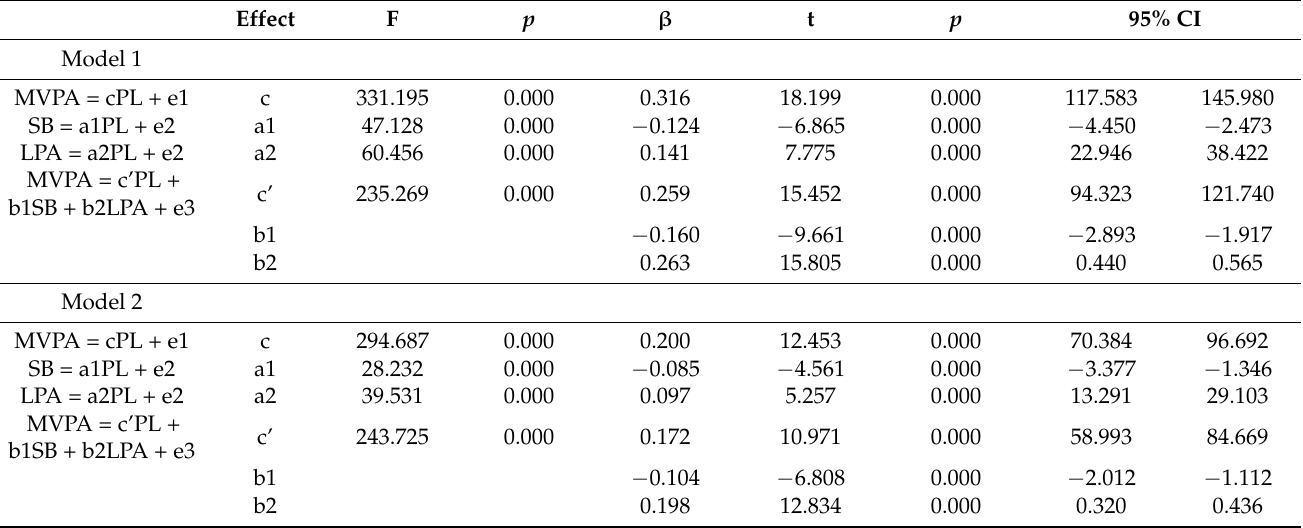
Table 5. Regression analysis of variable relationship.